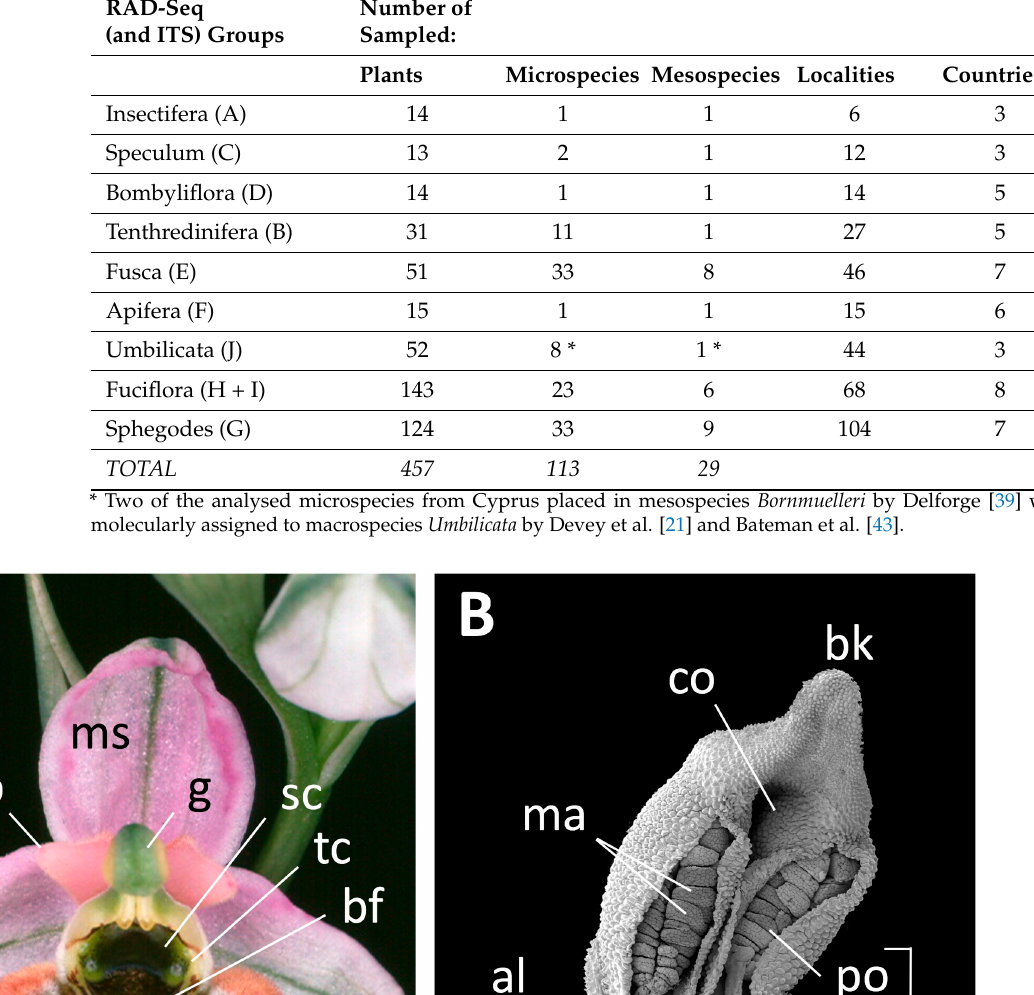
Table 1. Summary of plants subjected to morphometric analysis in the present study, organised according to nine molecularly circumscribed macrospecies. RAD-Seq (and ITS) Groups